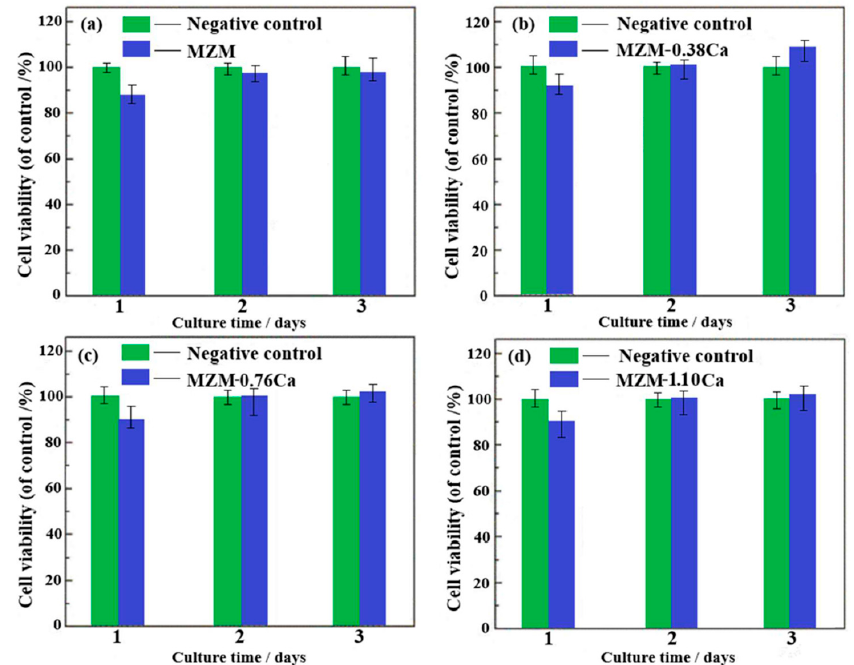
Figure 11. The BMSCs viability in negative control and MZM-xCa alloys extractions after one, two and three days of culture. ( a ) MZM; ( b ) MZM-0.38% Ca; ( c ) MZM-0.76% Ca; and ( d ) MZM-1.10% Ca.